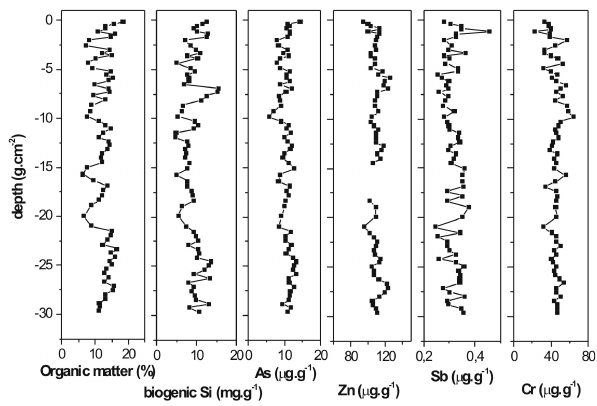
Fig. 6. Lake Tonˇcek sedimentary sequence. Organic matter, bio- genic Si and heavy metals concentration profiles.